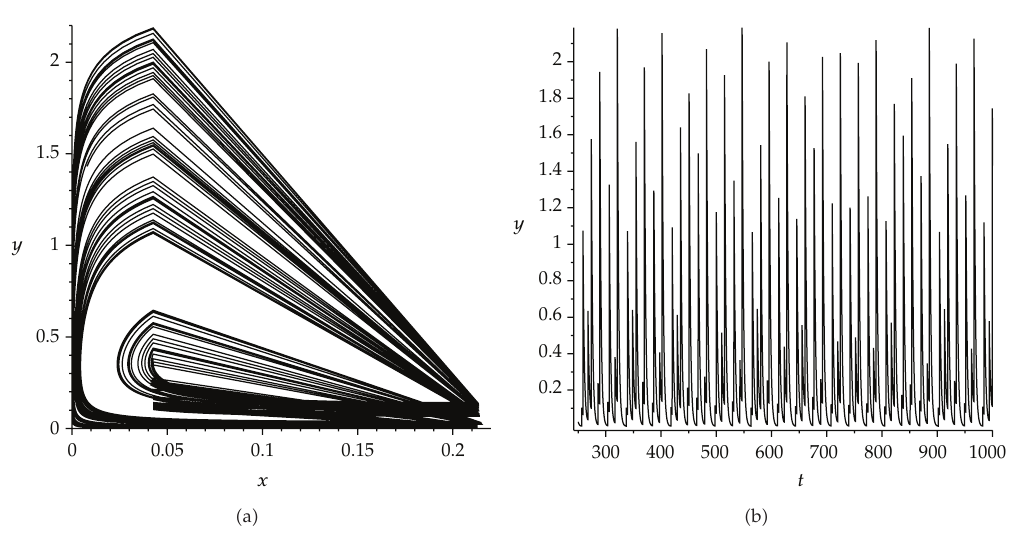
Figure 5: (cid:7) a (cid:8) Phase diagram; (cid:7) b (cid:8) time series of y for system (cid:7) 1.1 (cid:8) with h (cid:6) 0.21, p (cid:6) 0.8, τ (cid:6) 0 . 065, q (cid:6)